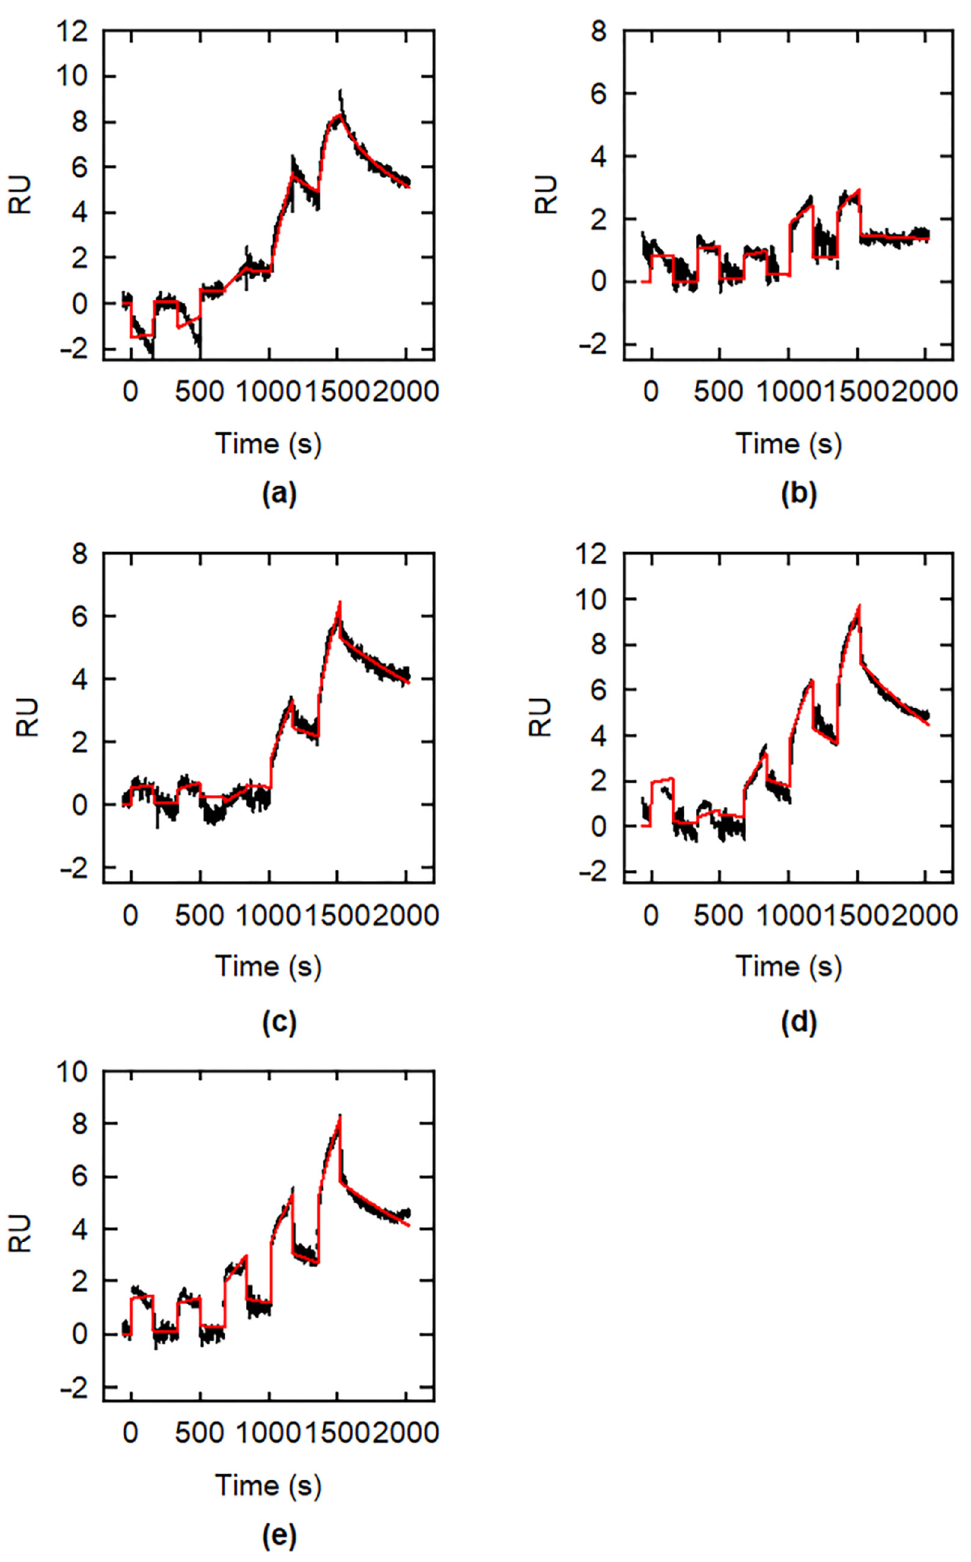
Figure 2. Kinetics of formation of StCS complex in the absence ( a ) and in the presence of 0.15 µM ( b ), 0.3 µM ( c ), 1 µM ( d ) or 2 µM ( e ) UPAR415. Data were fitted to the Langmuir 1:1 binding model (red lines). SAT was injected at five sequential concentrations of 0.5, 2.5, 5, 25, and 50 nM ( a – c ) or 2.5, 5, 25, 50, and 100 nM ( d , e ). Protein concentrations are expressed as monomers.